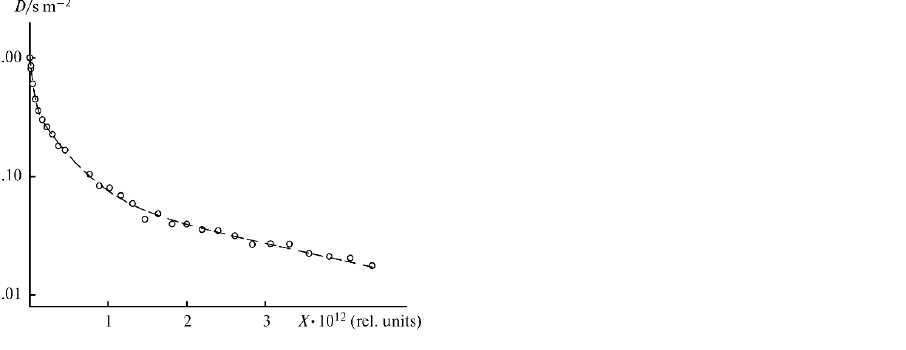
Figure 20. 1 H diffusion decay of PGE containing 12% EC wt % (sample 4, Table 1) and its approxima- tion (dashes), X = γ 2 g 2 δ 2 ( ∆ — δ /3) [54].